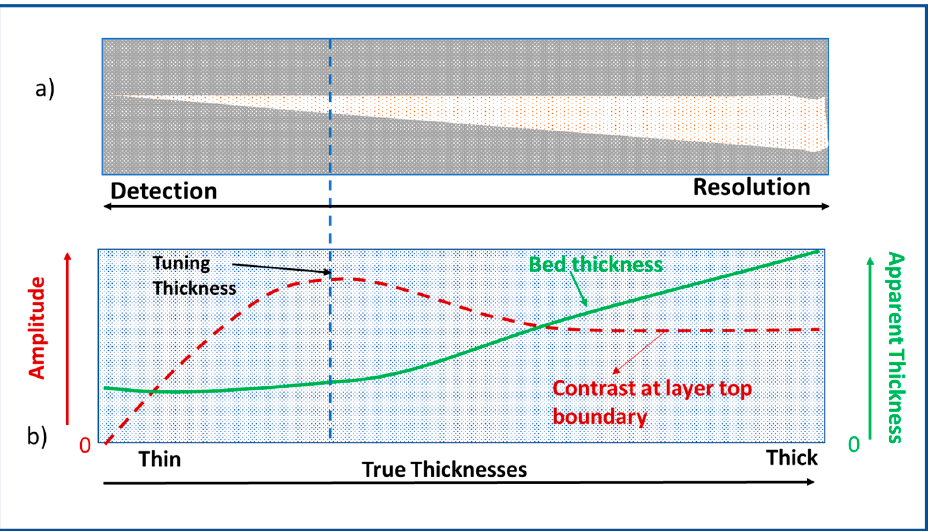
Figure 1. Synthetic seismic response of a theoretical wedge model, ( a ) wedge and seismic traces, ( b ) amplitude extracted from top/base seismic marker (red) and measured through to peak time distance (green).